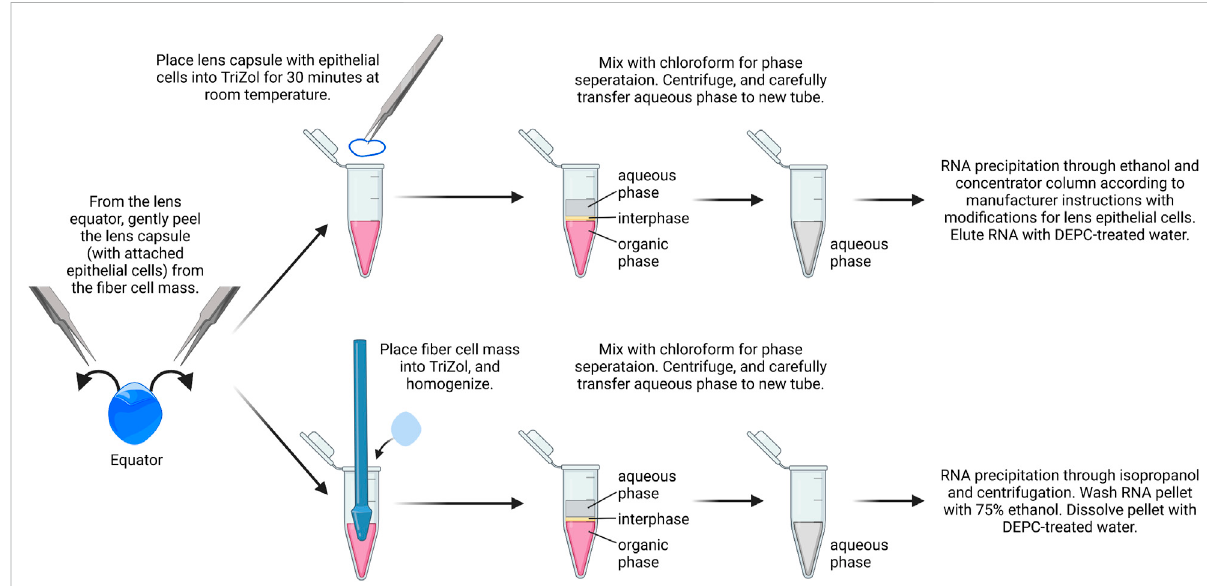
FIGURE 2 RNA isolation from lens epithelial cells. Capsules are isolated from lenses and placed in TRIzol. Chloroform is added for phase separation, and RNA is precipitated using ethanol followed by RNA clean up using spin columns. From the same samples, the fi ber cell RNA can also be isolated with standard TRIzol/chloroform extraction, isopropanol precipitation, and ethanol wash. The image was drawn using Biorender and not drawn to